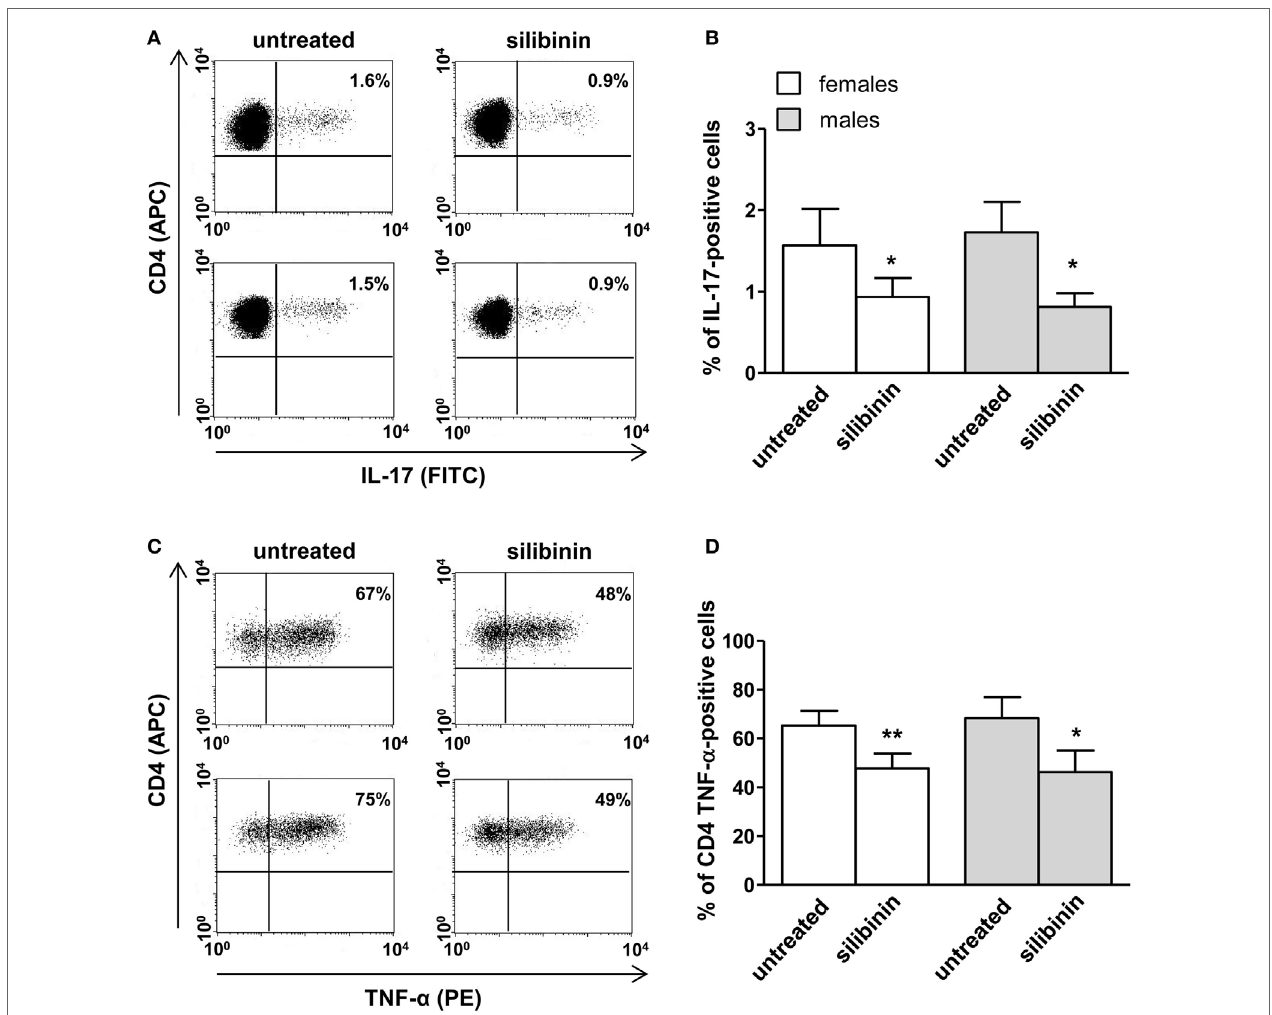
FigUre 6 | Silibinin-dependent effects on IL-17 and TNF- α expression in peripheral blood T lymphocytes from rheumatoid arthritis (RA) patients. T lymphocytes from 10 female and 4 male RA patients were evaluated by flow cytometry for cytokine production after 48 h of culture with silibinin and stimulation with phorbol myristate acetate (PMA) and ionomycin in the presence of brefeldin as detailed in Section “Materials and Methods.” Results from representative female (upper panels) and male (lower panels) RA patients are shown (a,c) . Data are also reported as mean ± SD (b,D) . * P < 0.05, ** P < 0.01 versus untreated